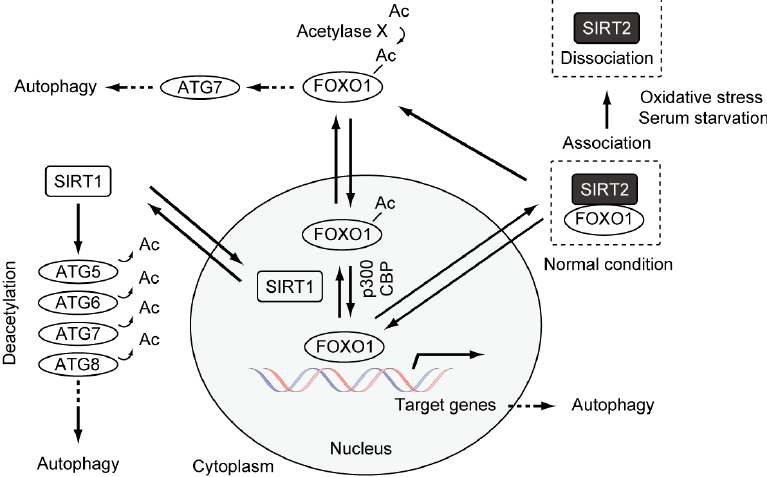
Figure 3. Autophagy regulation by SIRT1, SIRT2, and FOXO1.The autophagy levels are increased and decreased by SIRT1 and SIRT2, respectively. FOXO1 regulates the expression of multiple autophagy-related genes, including ATG5, ATG6, ATG8, ATG12, Rab7 (a member of RAS-related GTP-binding proteins), and Bnip3 (BCL2/Adenovirus E1B 19kDa Interacting Protein 3) [55–59]. There are at least six ATG8 homologues in mammalian cells, and LC3 is one of the ATG8 homologues.